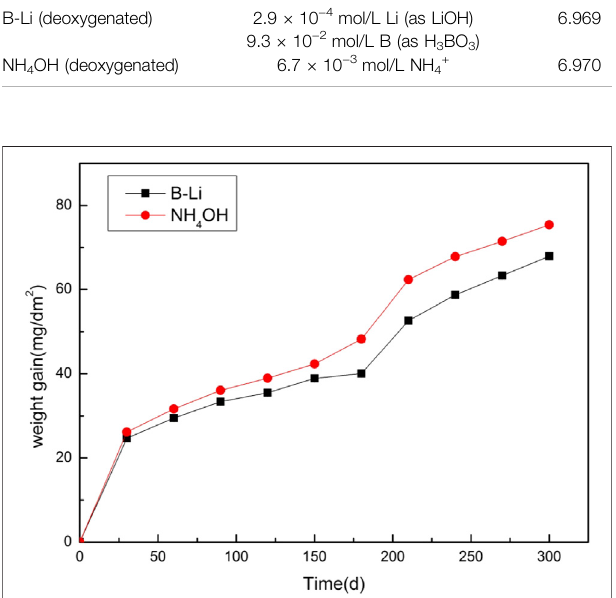
FIGURE1| Weightgain curves ofthe Zr – Sn – Nb alloy inthetwotypes of aqueous solutions.